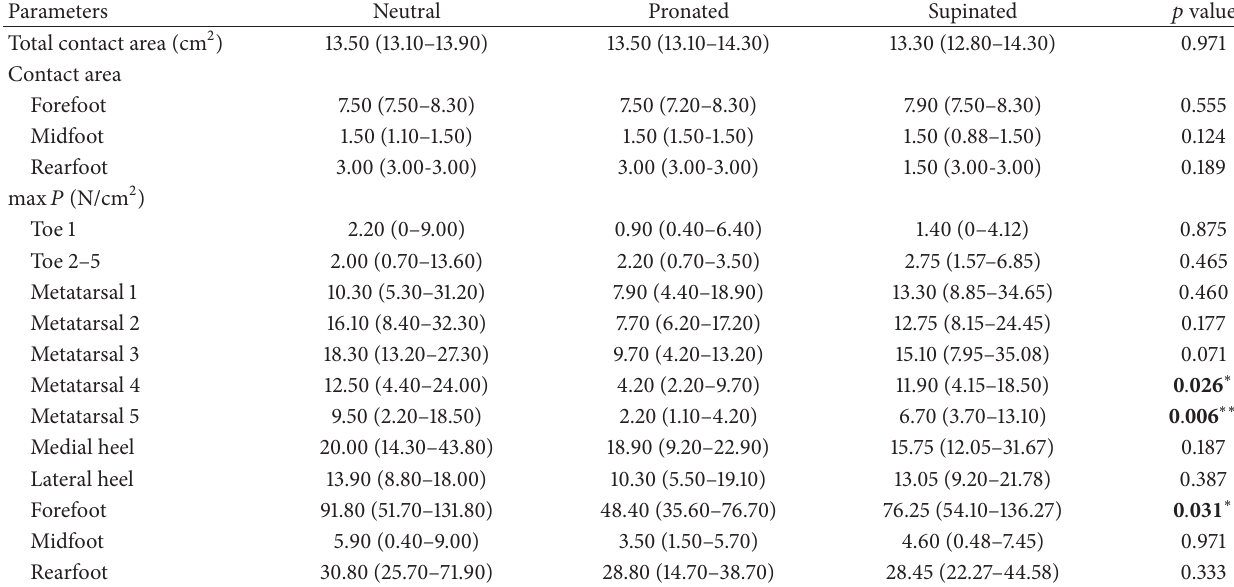
Table 2: Plantar pressure analysis among left and right foot between groups (neutral, pronated, and supinated foot); dynamic pressure (median